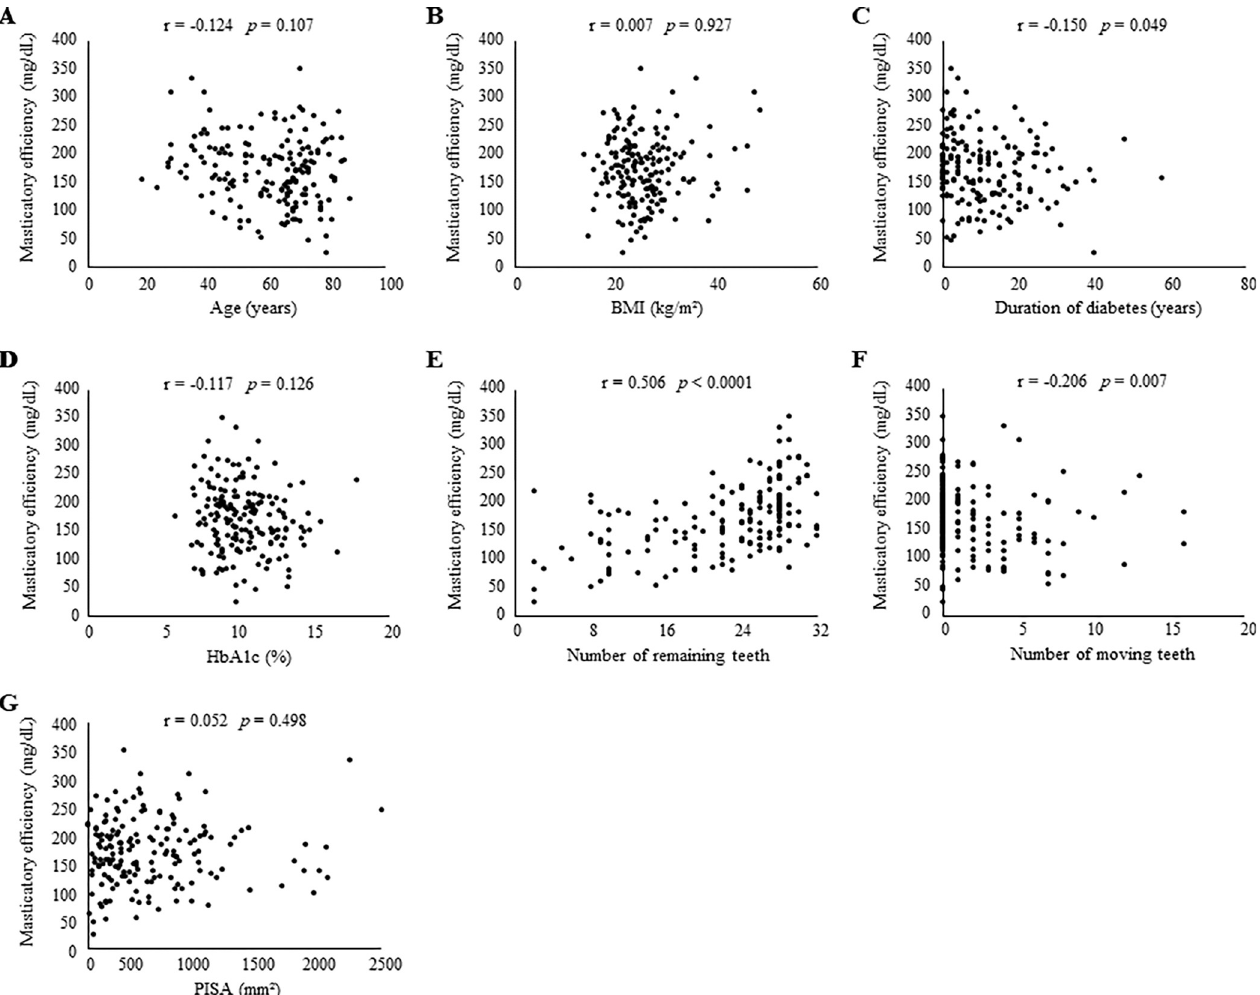
Fig 1. Spearman rank correlation. Correlations between masticatory efficiency and (A) age, (B) BMI, (C) duration of diabetes, (D) HbA1c, (E) number of remaining teeth, (F) number of moving teeth and (G) PISA were assessed. Spearman rank correlation coefficients (r) and p values ( p ) are shown. Statistical significance was defined as a two-sided p value of < 0.05. Abbreviations: BMI, body mass index; HbA1c, hemoglobin A1c; PISA, periodontal inflammatory surface